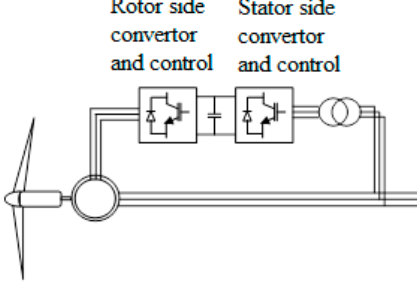
Figure 1. The arrangement of a DFIG driven by a wind turbine.